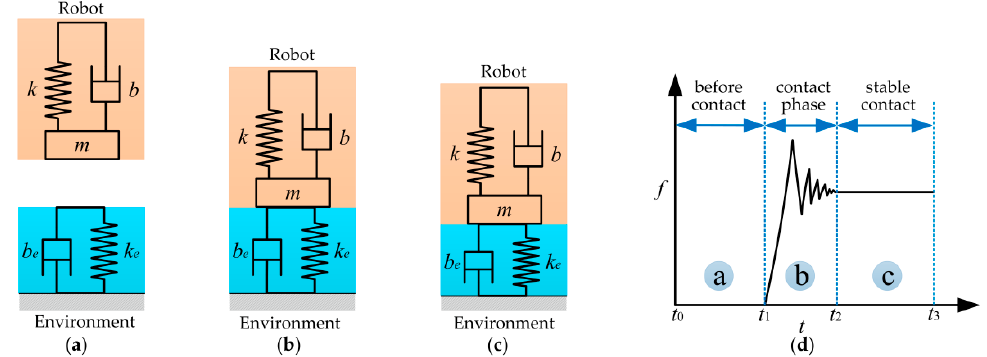
Figure 1. The interaction model of the system. ( a ) Without any contact between the robot and the environment; ( b ) critical point when contact occurs; ( c ) stable contact with the environment; ( d ) contact force diagram when robot comes in contact with the environment.